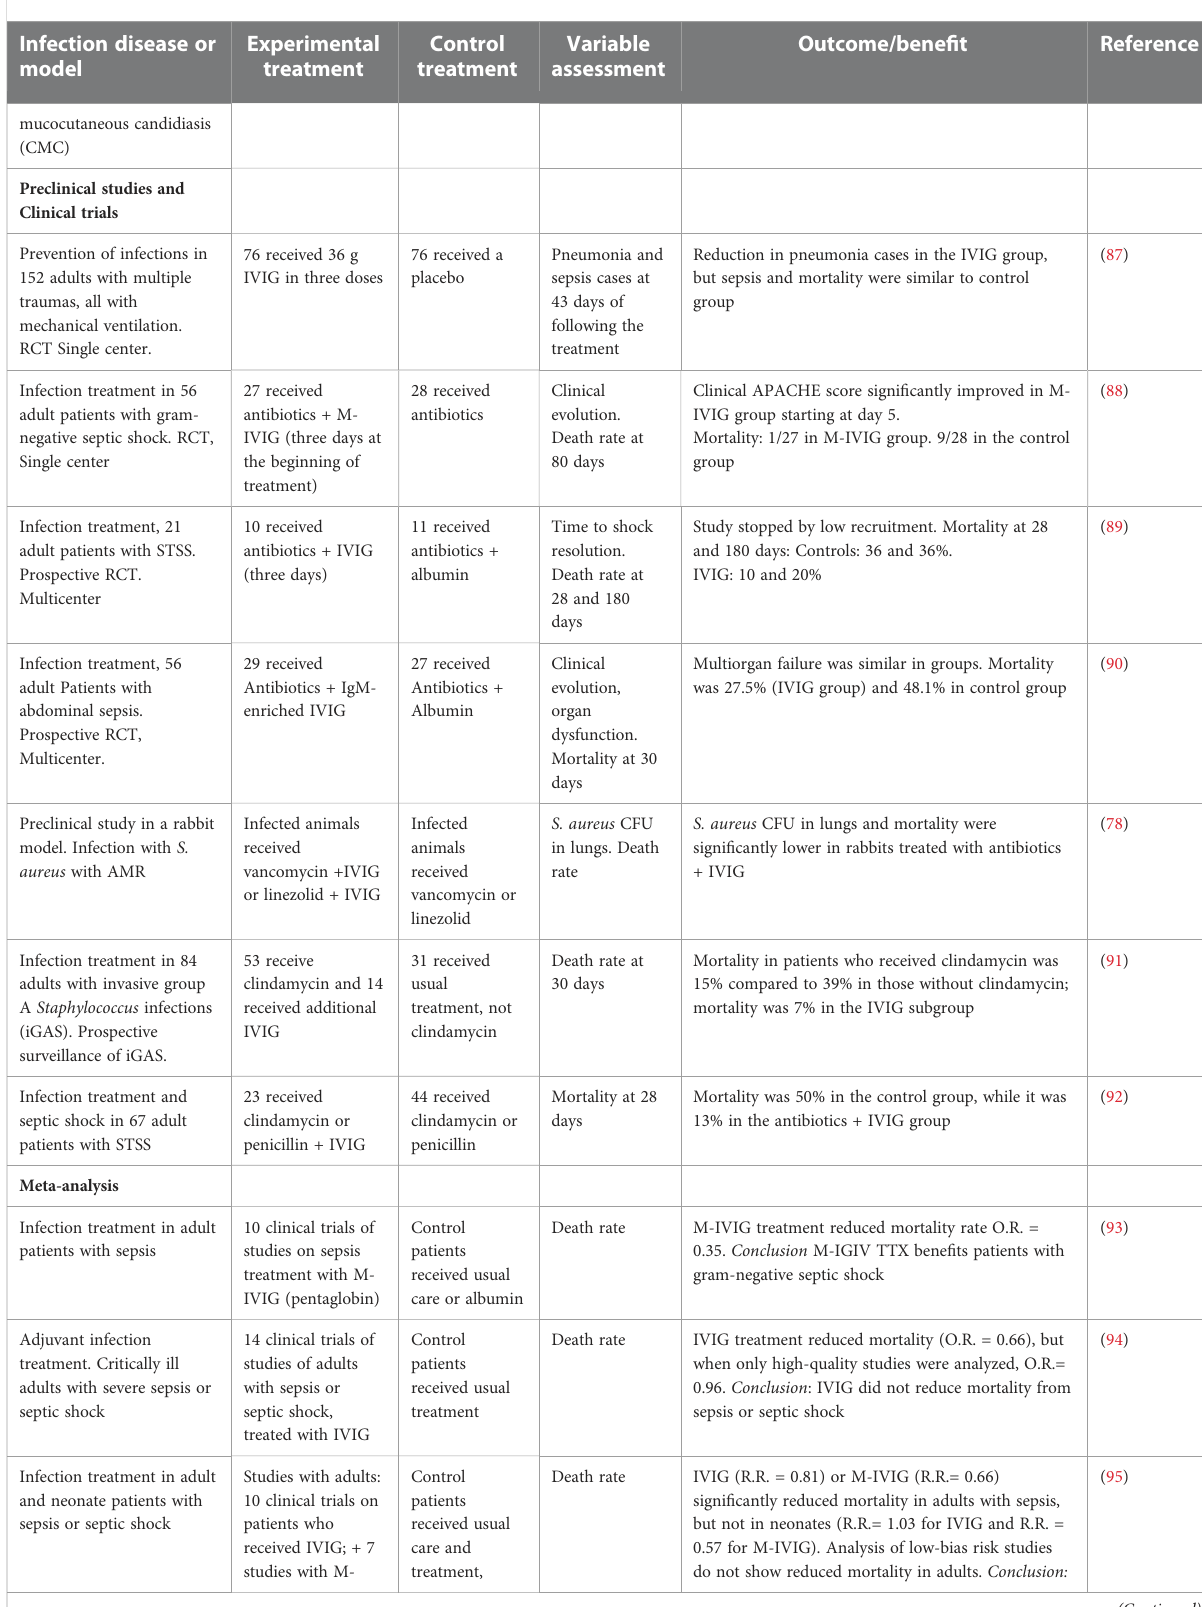
IVIG (R.R. = 0.81) or M-IVIG (R.R.= 0.66) signi fi cantly reduced mortality in adults with sepsis, but not in neonates (R.R.= 1.03 for IVIG and R.R. = 0.57 for M-IVIG). Analysis of low-bias risk